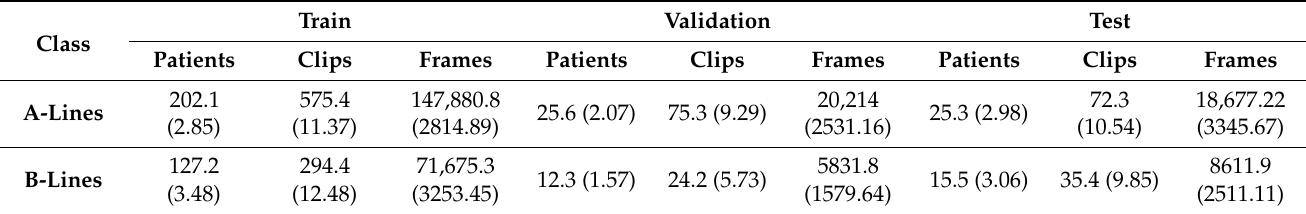
Table 3. K-fold cross-validation experiment data distribution averages and standard deviations across all folds (full results are provided in the Supplementary Materials and Table